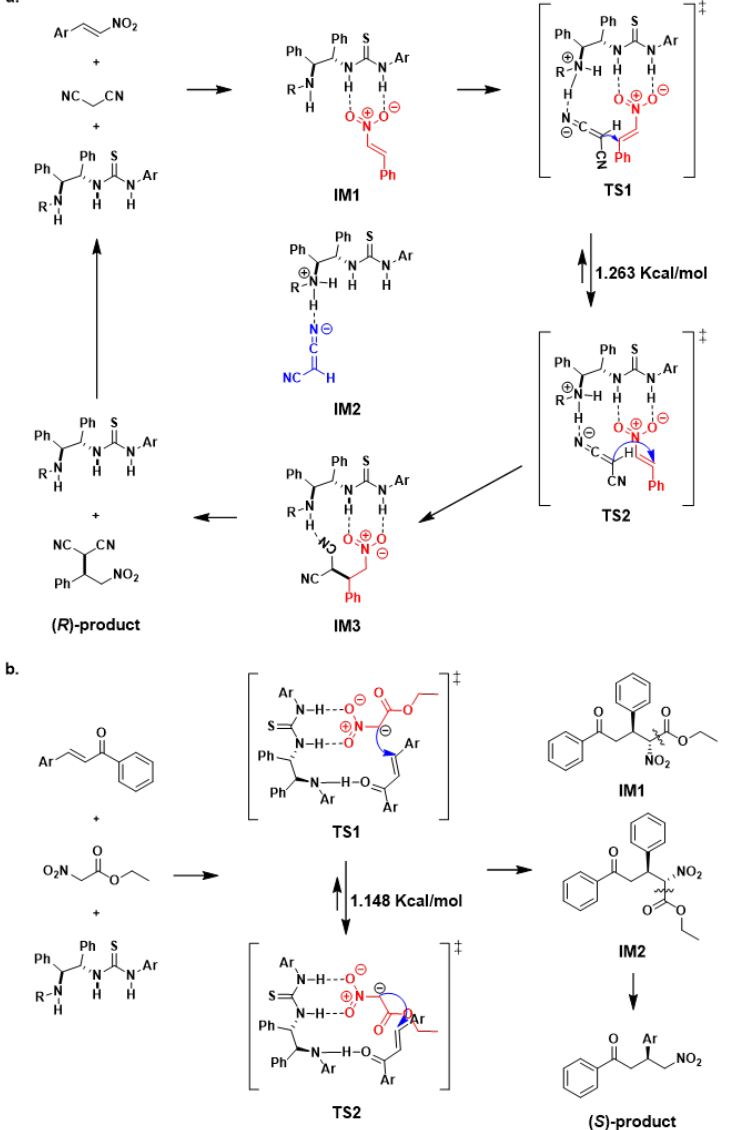
Figure 4. Reaction mechanism inferred through expected transition states. ( R , R )-1,2-diphenyleth- ylenediamine (DPEN)-thiourea-catalyzed enantioselective Michael reaction calculated at the B3LYP/6-31G(d,p) level. ( a ) Expected R -form products mechanism of the substrate for Michael reaction. ( b ) Mechanism of expected S -form products of the Michael reaction.